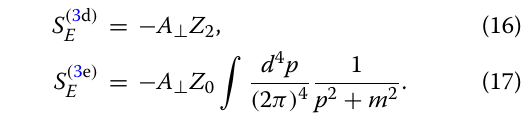
dimension two. Now we see all the couplings and propa- gators at O ((cid:4)) are proportional to A ⊥ , so every diagram at O ((cid:4)) is proportional to A ⊥ as well.